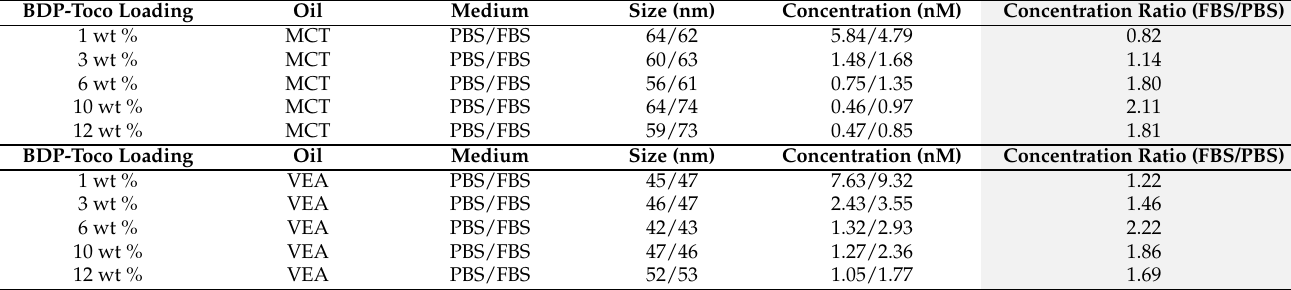
Table 4. Assessment of the dye leakage by Fluorescence Correlation Spectroscopy (FCS). BDP-Toco